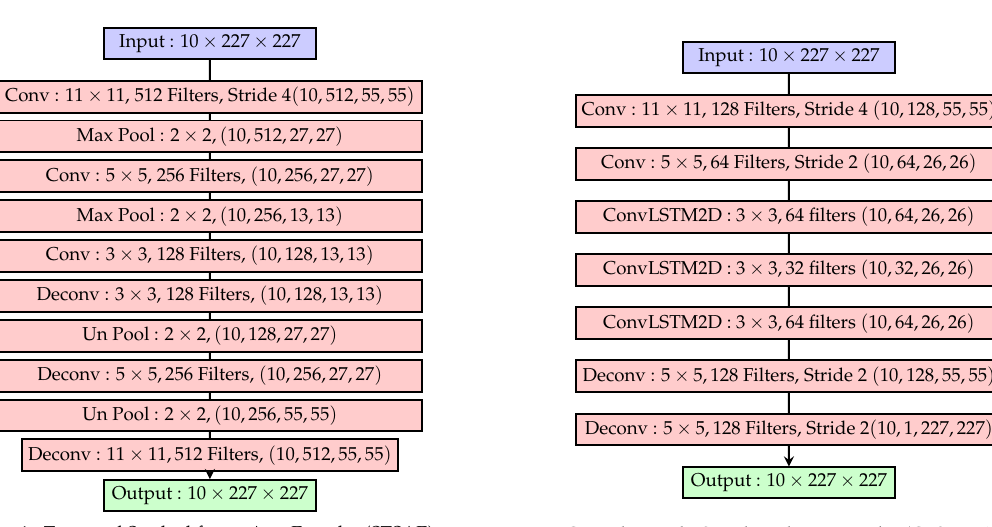
Figure 4. Spatio-Temporal Stacked frame AutoEncoder ( left ): A sequence of 10 frames are being reconstructed by a convolutional autoencoder, image reproduced from [41]. Convolutional LSTM based autoencoder ( right ): A sequence of 10 frames are being reconstructed by a spatio-temporal autoencoder, [42]. The Convolutional LSTM layers are predictive models that model the spatio-temporal correlation of pixels in the video. This is described in the predictive model